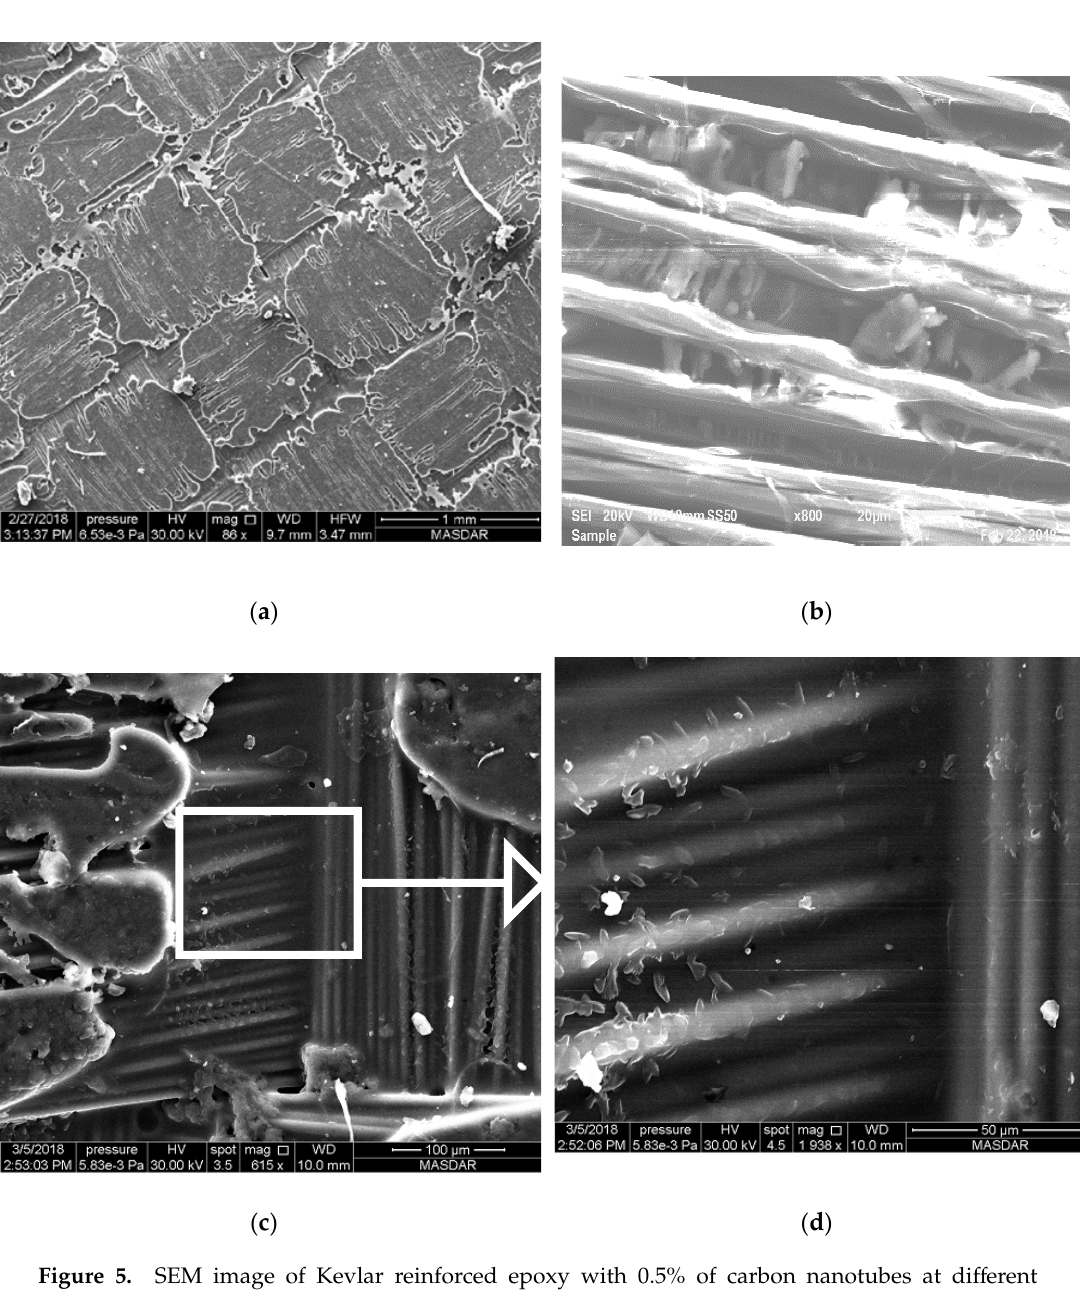
Figure 5. SEM image of Kevlar reinforced epoxy with 0.5% of carbon nanotubes at different magnifications. ( a ) 88×, ( b ) 8000× ( c ) 615× ( d ) 1938×.